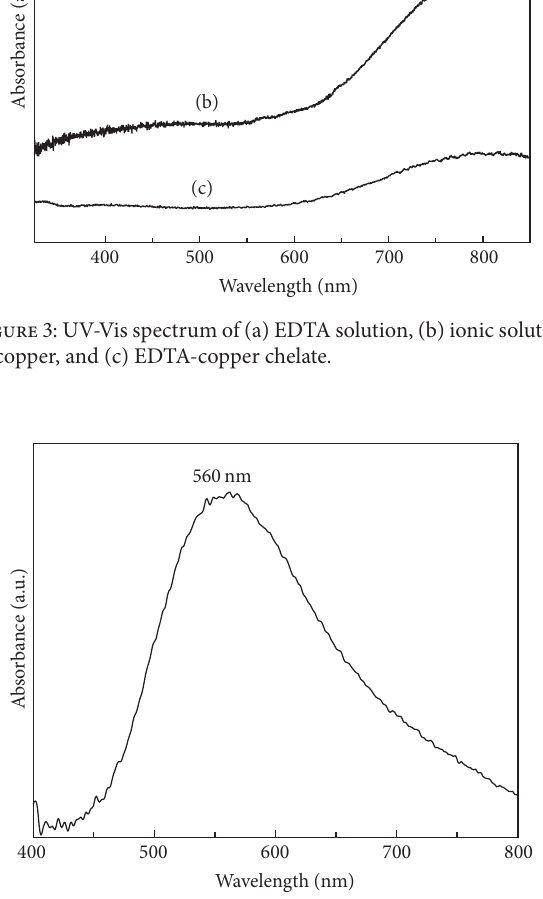
Figure 4: UV-Vis of copper nanoparticles